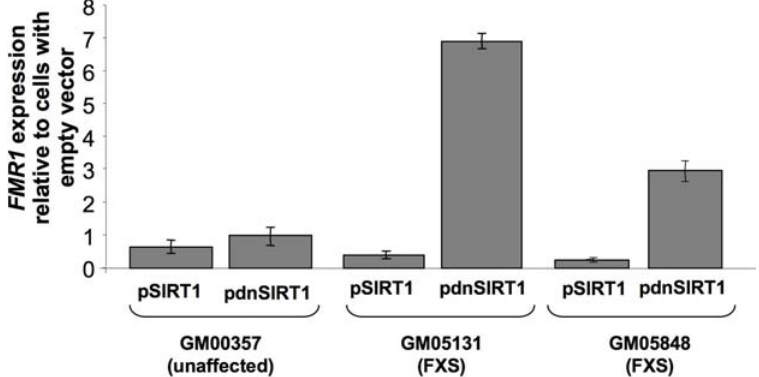
Figure 3. The effect of SIRT1 on FMR1 gene expression. Vectors expressing either SIRT1 or a dominant negative version of SIRT1 (dnSIRT1) were transfected into fibroblasts from an unaffected individual and individuals with FXS. After 48 hrs FMR1 mRNA levels were measured by real time PCR and plotted relative to the FMR1 mRNA produced from cells transfected with empty vector. The results represent the average and standard deviations of 3 independent